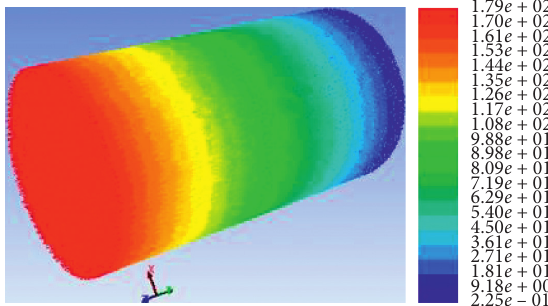
Figure 16: Flame cylinder velocity vector cloud diagram.